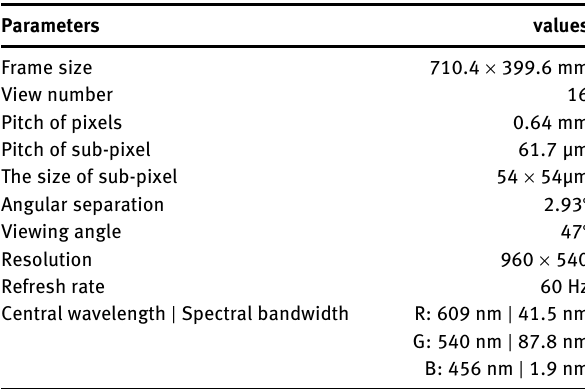
Table  : Typical parameters of the prototype for  -inch glasses- free augmented